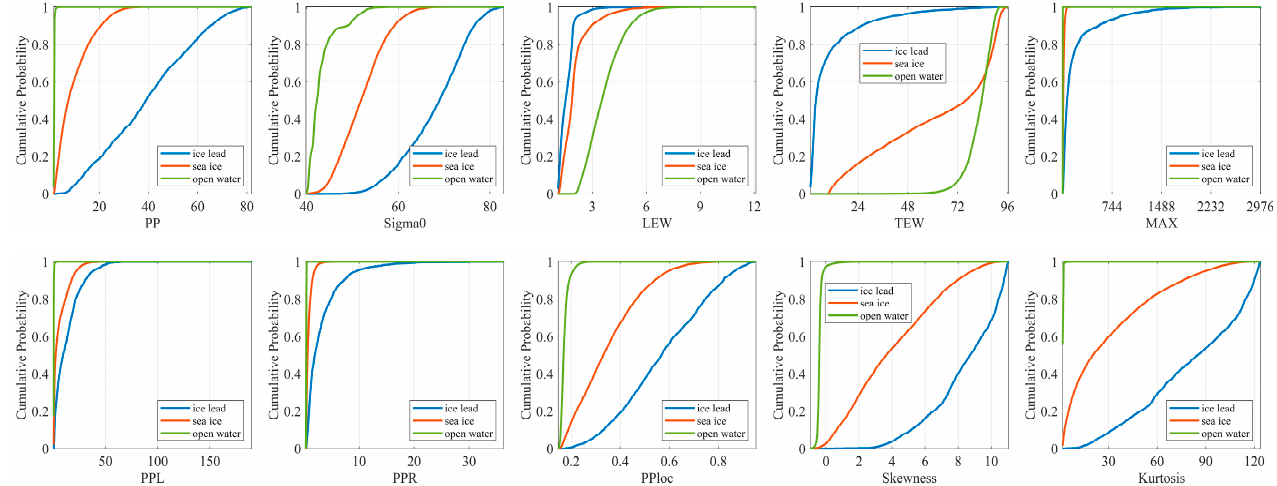
Figure 8. The cumulative probability for different waveform characteristic parameters.